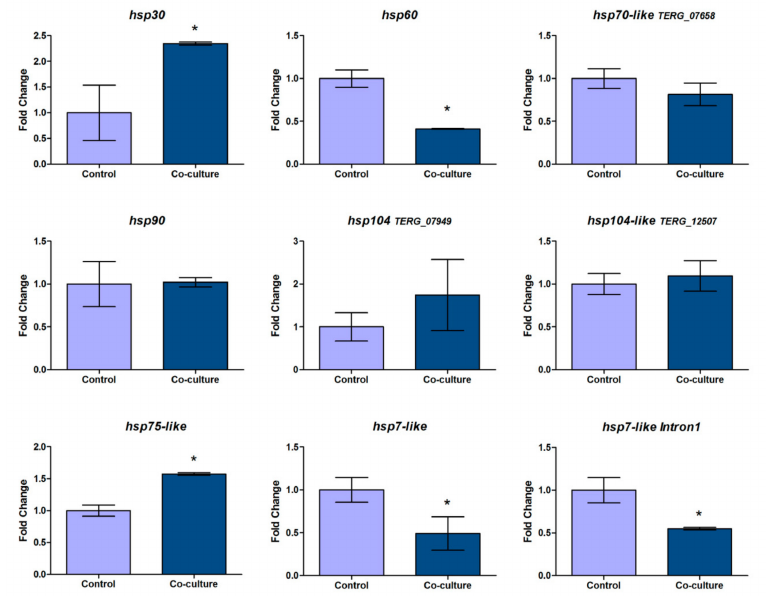
Figure 4. qPCR results for the HSP expression profile of T. rubrum after co-culture with human keratinocytes. Expression levels for each condition are represented in comparison to the control ( T. rubrum grown alone). Data are means ± SD. Significant statistical di ff erences are represented by asterisks (* p <